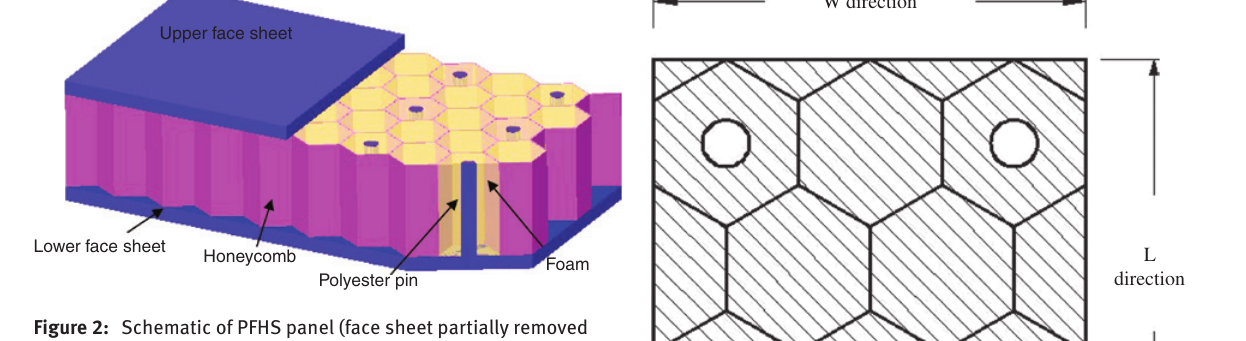
Figure 2: Schematic of PFHS panel (face sheet partially removed and sectioned the honeycomb core to show pins).